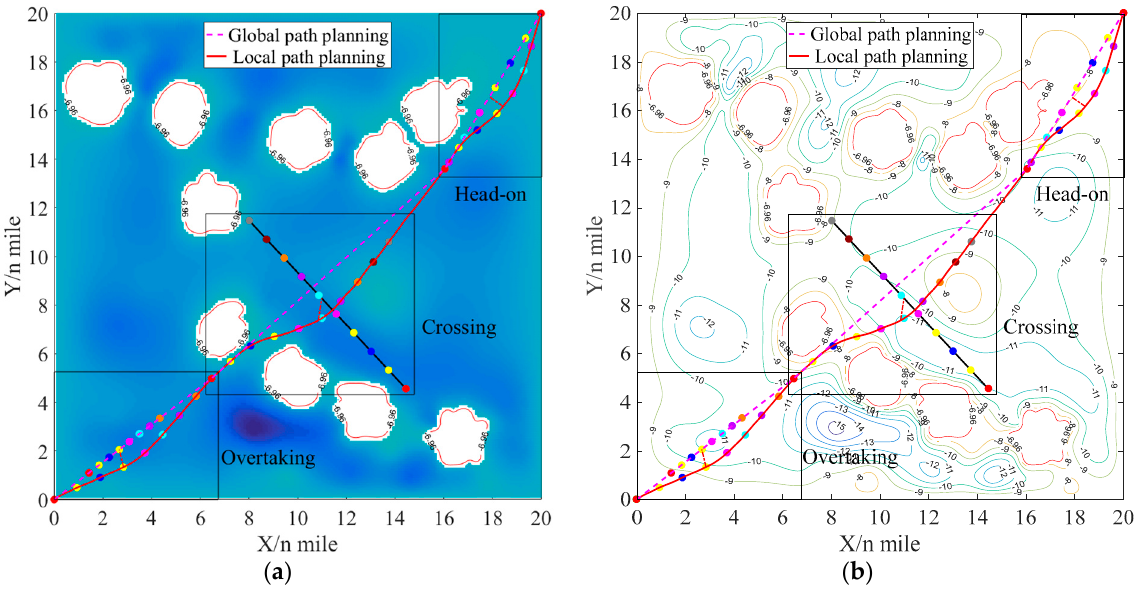
Figure 19. Comparison the results of global path planning and local path planning. ( a ) Navigable map. ( b ) Depth contour.